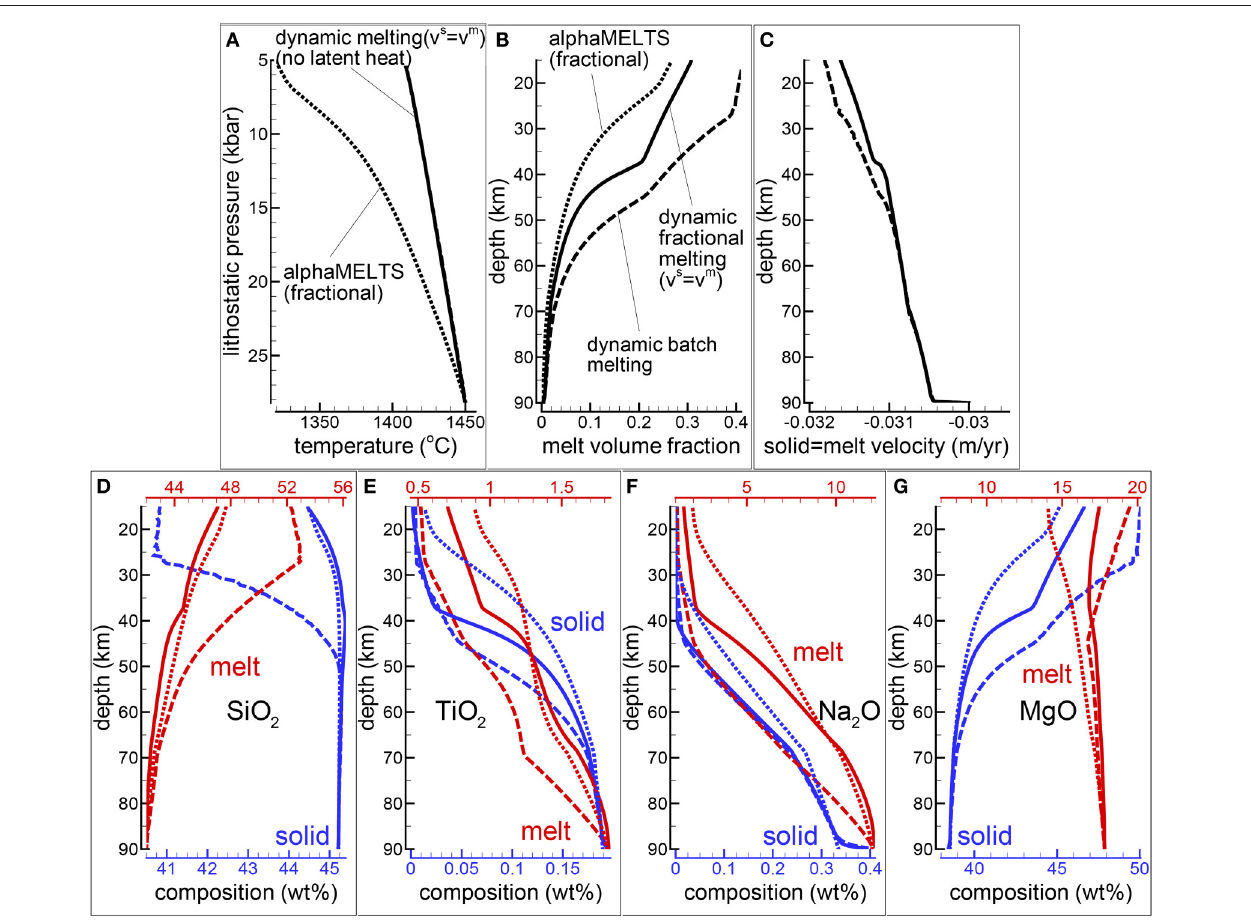
FIGURE 2 | Dynamic melting with v melt = v solid . Comparison between dynamic batch melting (dashed lines) and the DFM model with v melt = v solid (solid lines). The dynamic batch melting model has been already presented in MF1. The dotted lines show the results for a fractional melting model using AlphaMELTS. For the simulation of the DFM model with v melt = v solid , number of grid points nz = 300, number of time steps between two thermodynamic calculations nthermo = 8. (A) Temperature vs. lithostatic pressure, (B) variation of the melt volume fraction with depth, (C) solid and melt velocity, (D–G) composition of the solid and melt (wt %), (D) SiO 2 , (E) TiO 2 , (F) Na 2 O , (G) MgO . The plots show also the composition of the integrated melt (red dotted lines) and the residual solid (dotted blue lines) using AlphaMELTS (pMELTS version). The data file and an animation of the DFM simulation can be downloaded following the instructions in the Supplementary Material (data file PHASE3B-P.YRC00.DAT included in the zip file max-front2-data.zip , movie file mf2-movie1.PHASE3B-P.YRC00.avi